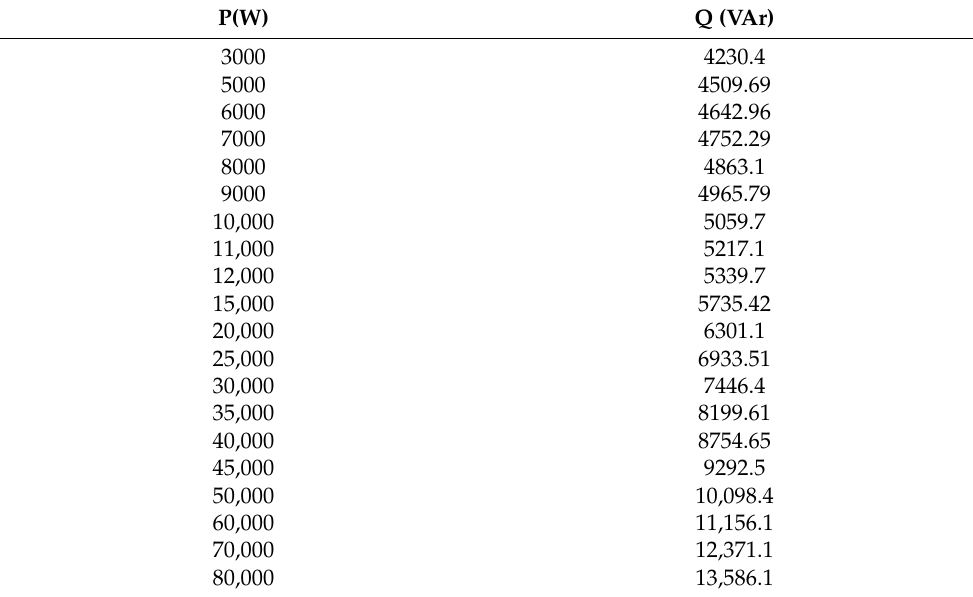
Table 3. Active and reactive power results with 50 Hz at the test